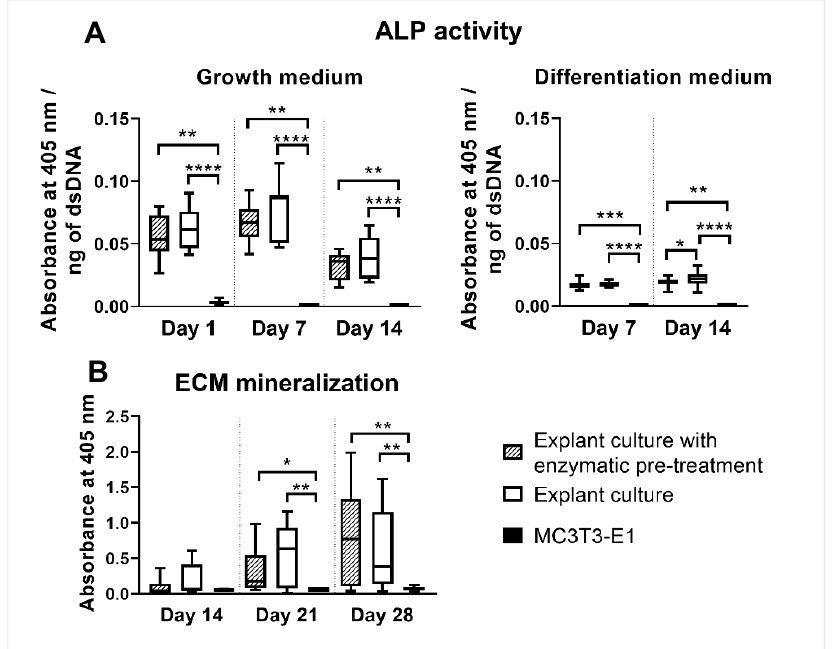
Figure 2. ALP activity ( A ) and quantified ECM mineralization ( B ) by rOBs isolated either by explant culture with enzymatic pre-treatment or by explant culture. MC3T3-E1 osteoblastic cell line served as a control. ALP activity normalized to the estimated amount of rOBs was assessed on days 1, 7, and 14. ECM mineralization was assessed on days 14, 21, and 28. Cells were cultured either in the growth or the differentiation medium. The statistical difference is marked as a link above the groups. * p < 0.05, ** p < 0.01, *** p < 0.001, **** p < 0.0001.